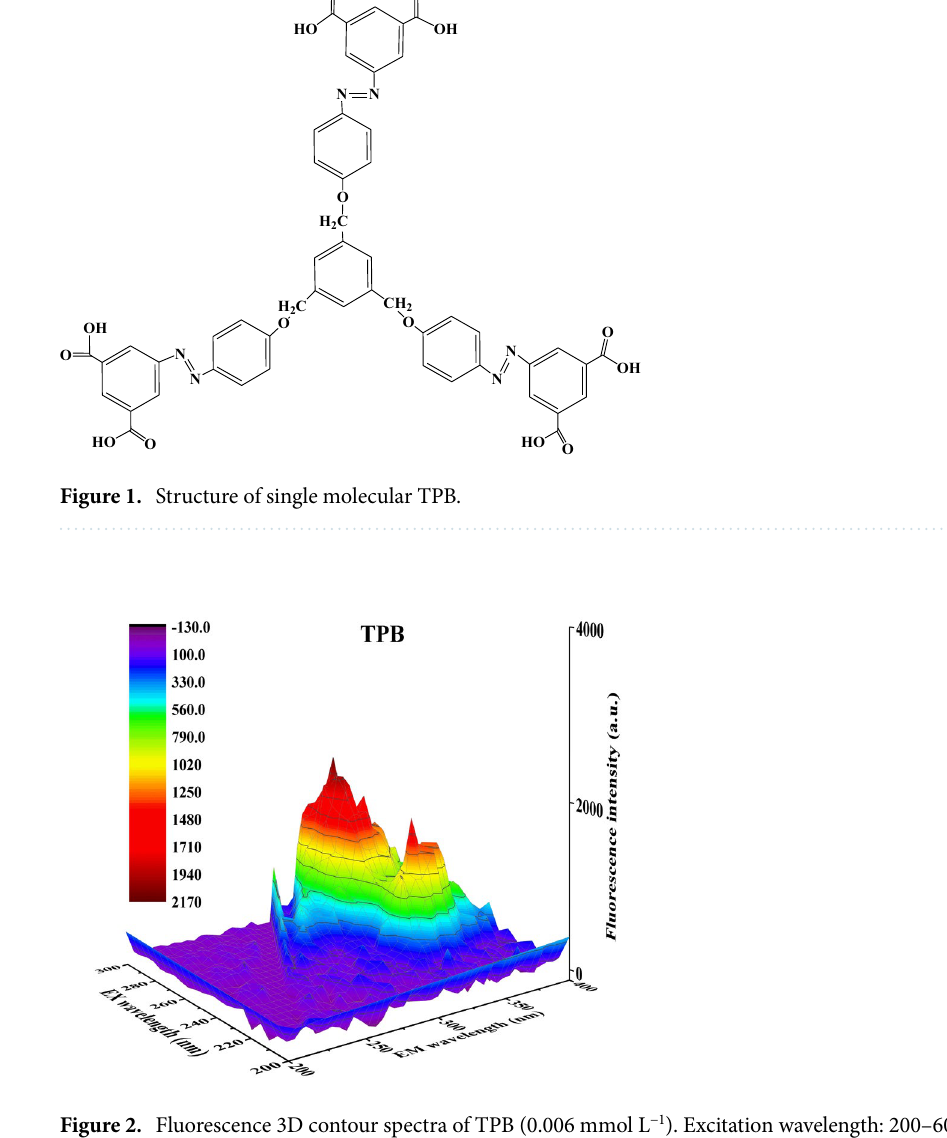
Figure 2. Fluorescence 3D contour spectra of TPB (0.006 mmol L −1 ). Excitation wavelength: 200–600 nm, Emission wavelength: 200–600